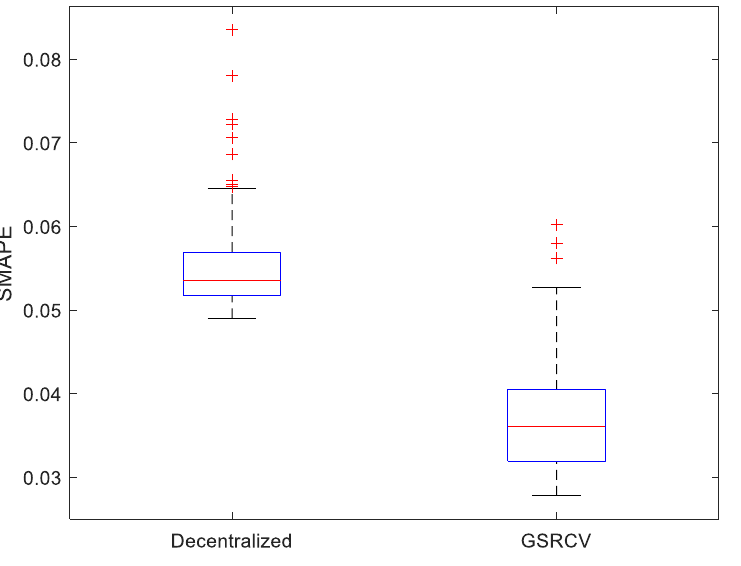
Figure 7. Accuracy results of different parameter optimization methods.